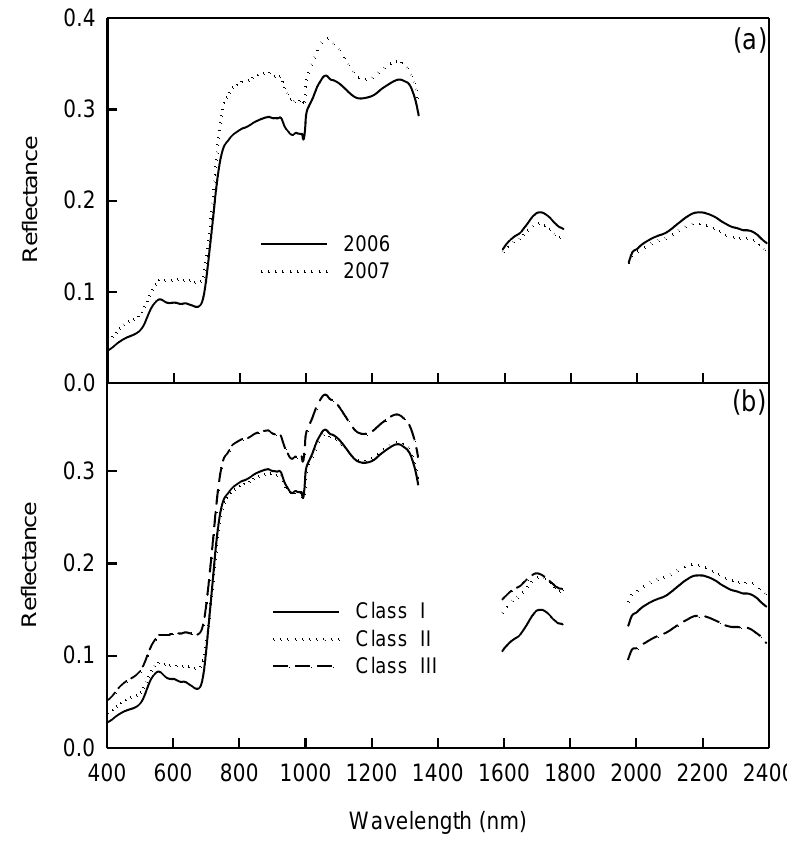
Figure 2. Changes in spectral reflectance of ( a ) 2006 and 2007; and ( b ) Class I, Class II, and Class III in Inner Mongolia.